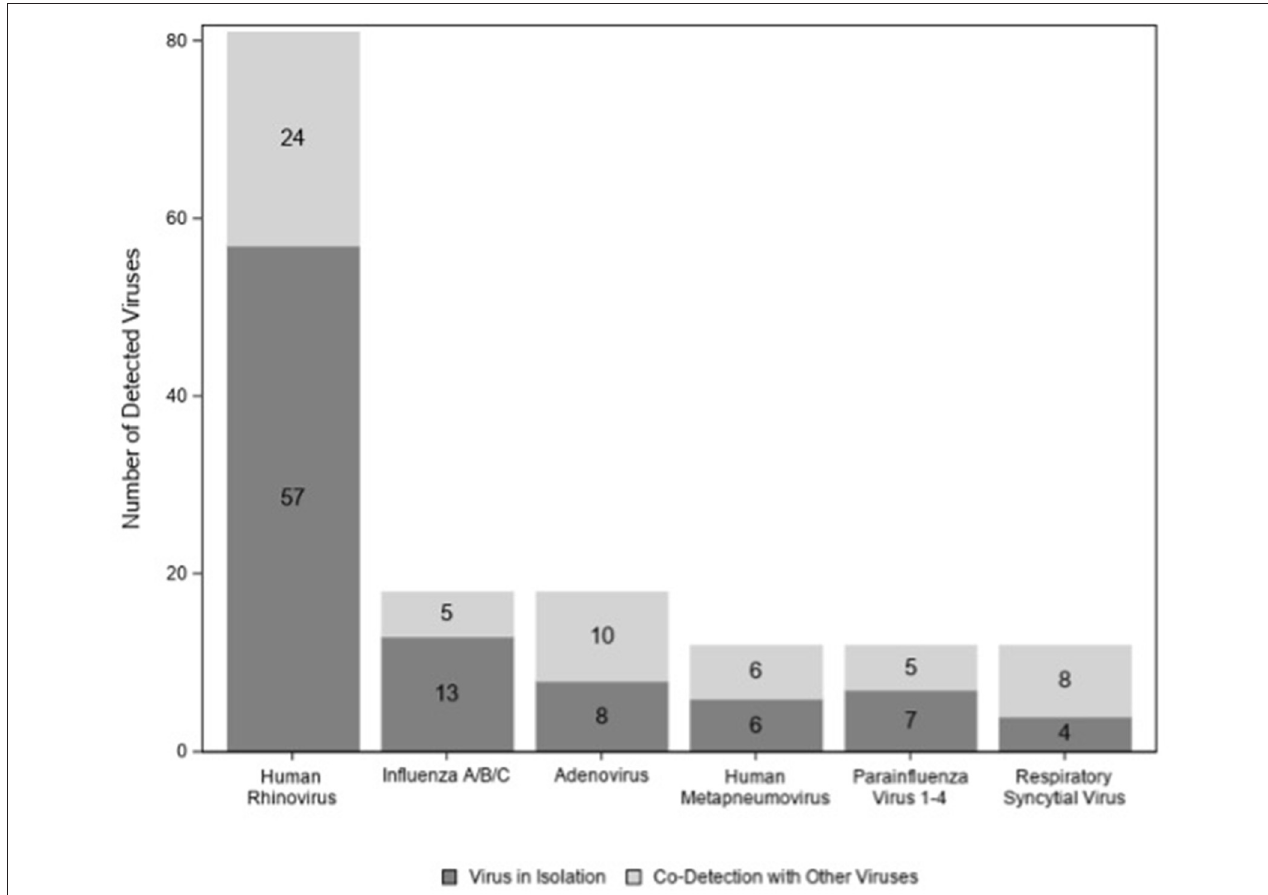
FIGURE 3 | Individual viruses detected among children with acute